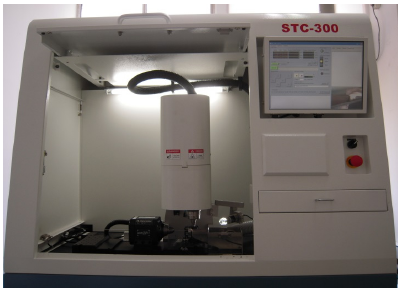
Figure 5. Integrated pulsed fiber laser module.